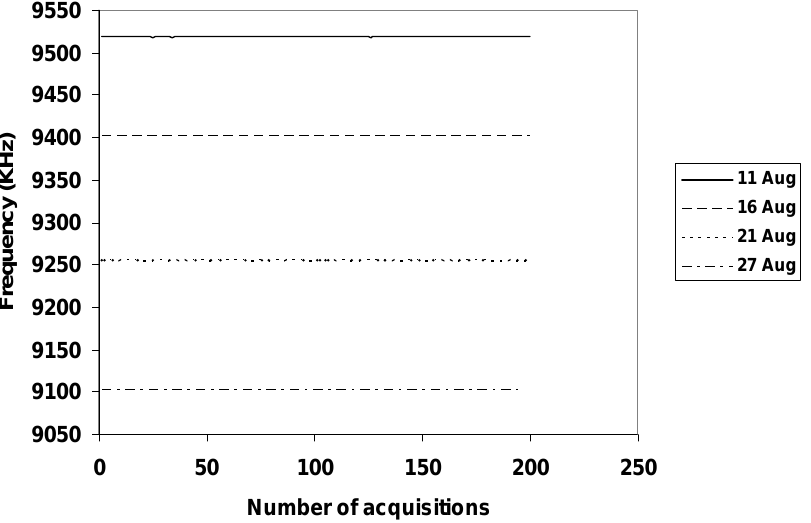
Figure 6. Variation of frequency in relation to the quantity of CO composite. Experimental data showed a linear absorption, coherently with the human activity of the sampling period.